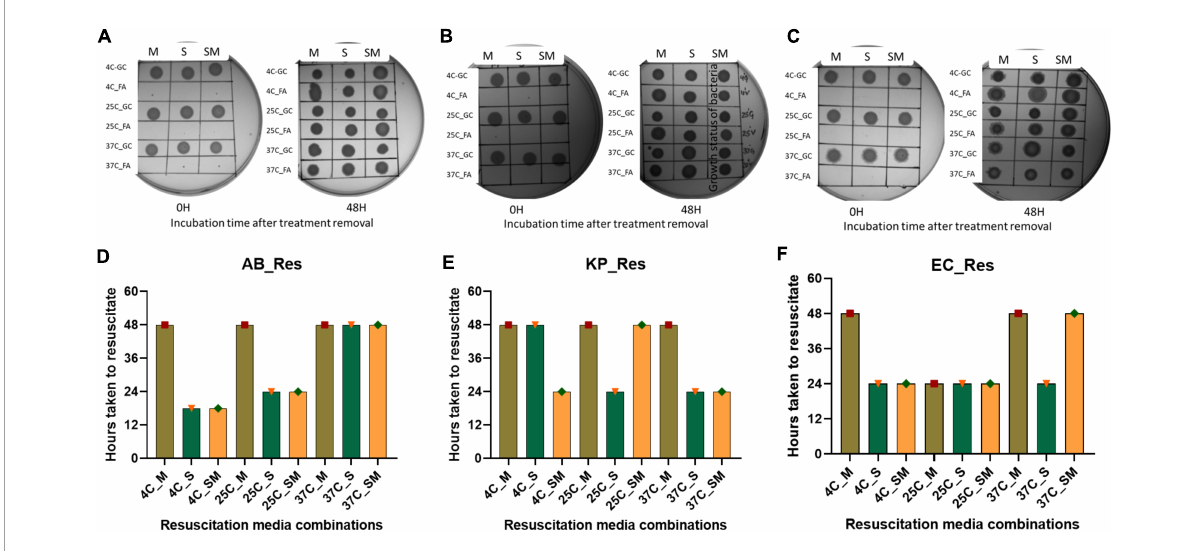
FIGURE5 Resuscitation of bacteria from viable-but-non-culturable (VBNC) state. VBNC bacteria was resuscitated by removal of formic acid (FA) treatment and addition of fresh media, spent media, and a combination of fresh and spent media (1:1) in this figure represents the growth of bacteria on agar plate and time taken for resuscitation. Cultural growth representation of Acinetobacter baumannii (A) , Klebsiella pneumoniae (B) , and E. coli (C) at 37 ◦ C incubation. Quantitative representation of Resuscitation was determined on the basis of time taken after removal of FA, Acinetobacter baumannii (D) , Klebsiella pneumoniae (E) , and E. coli (F) at 37 ◦ C incubation. Addition of spent media reduced the resuscitation time to 18 h which was formerly 48 h. FA, formic acid; GC, growing control; NVC, non-viable control; 4C, sample incubated at 4 ◦ C; 25C, sample incubated at 25 ◦ C; 37C, sample incubated at 37 ◦ C; D_2, sample tested after 2 days FA treatment; D_4, sample tested after 4 days of FA treatment; D_10, sample tested after 10 days of FA treatment; AB, Acinetobacter baumannii ; KP, Klebsiella pneumoniae ; EC, E. coli ; M, fresh media; S, spent media; SM, fresh media + spent